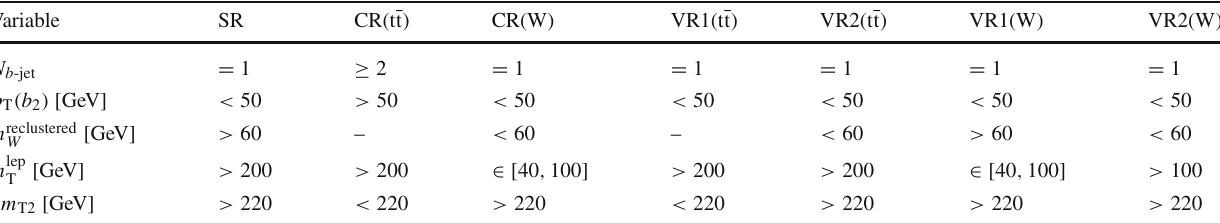
Table 3 Summary of signal, control and validation region definitions used in the tW 1L analysis channel. The ‘–’ entries represent an inclu- sive selection with no requirements. The W + jets control and validation